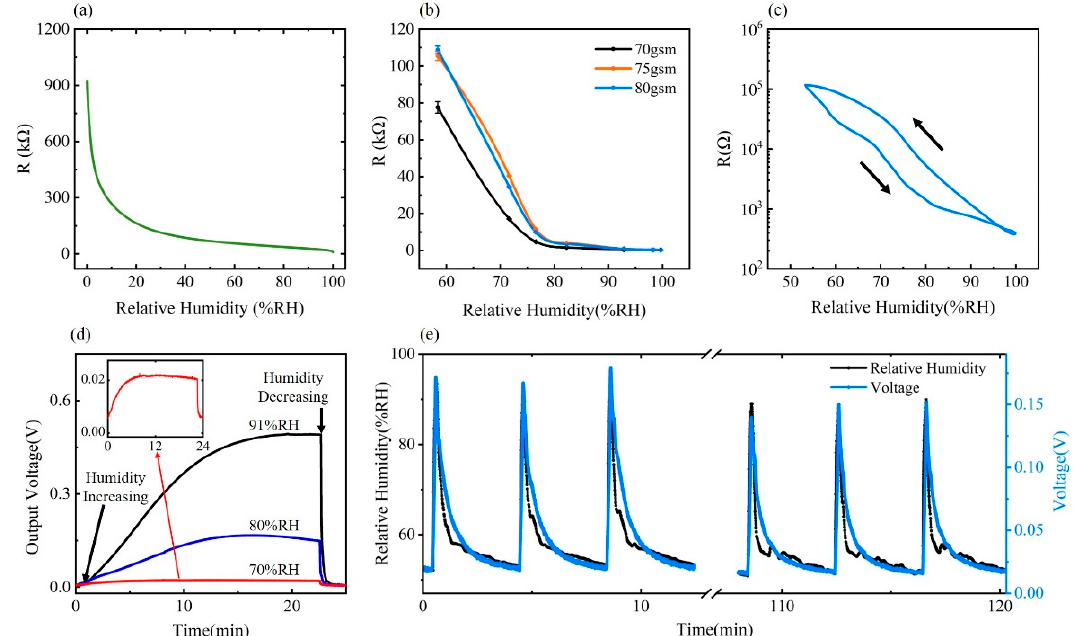
Figure 3. ( a ) Relationship between PHS resistance and relative humidity in paper humidity sensing model. ( b ) Resistance-RH% characteristic curve of PHSs under different design parameters. ( c ) Hysteretic curve of 80 gsm PHS. ( d ) Response time of 80 gsm PHS. ( e ) Repeatability of 80 gsm PHS.